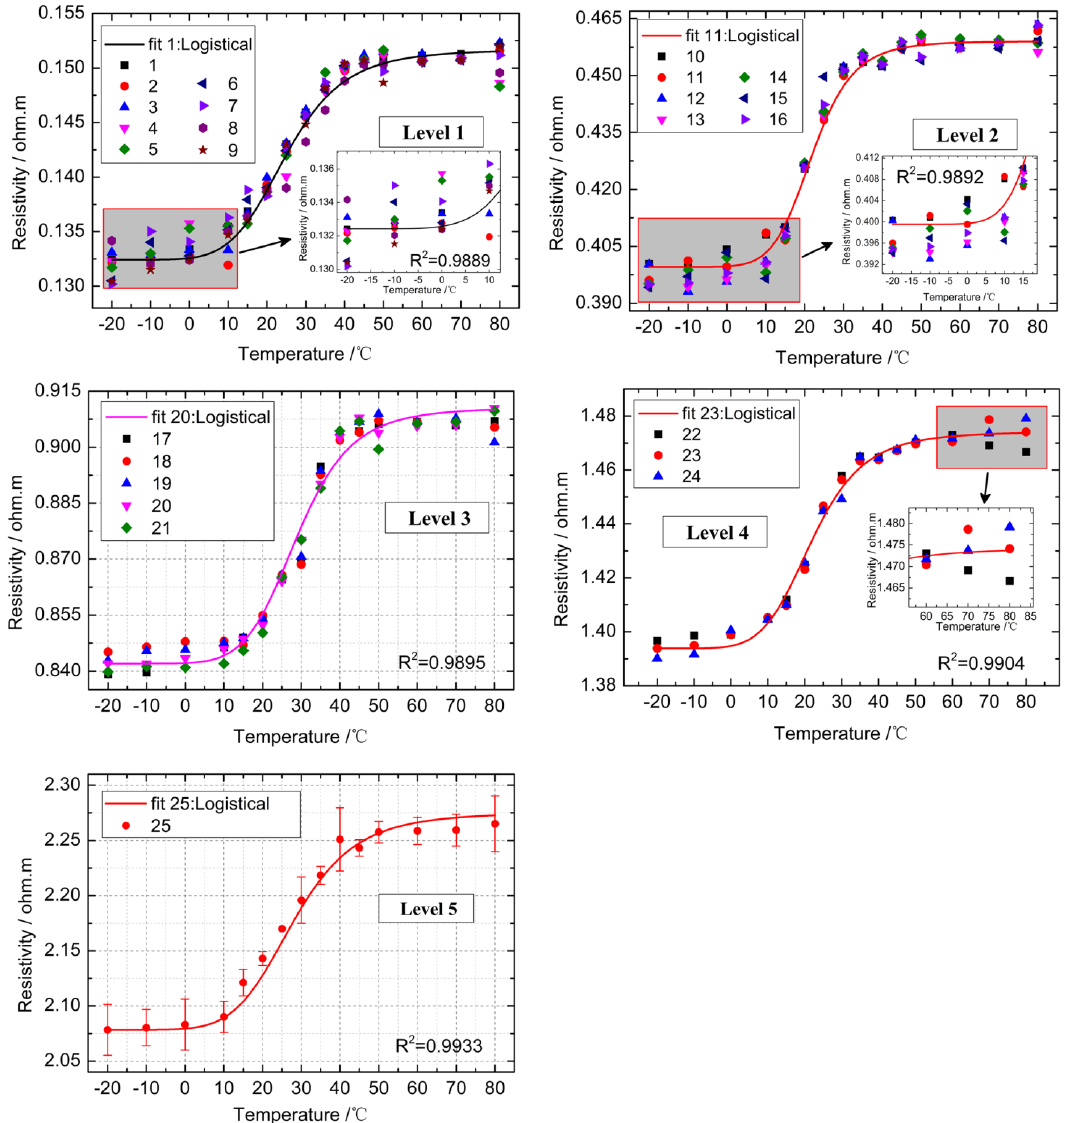
Figure 8. Variations of block resistivity ρ with temperature 𝑇 on side B of 10 Ah cell with SOC of 5%. All data in the graphs are the average of ten independent